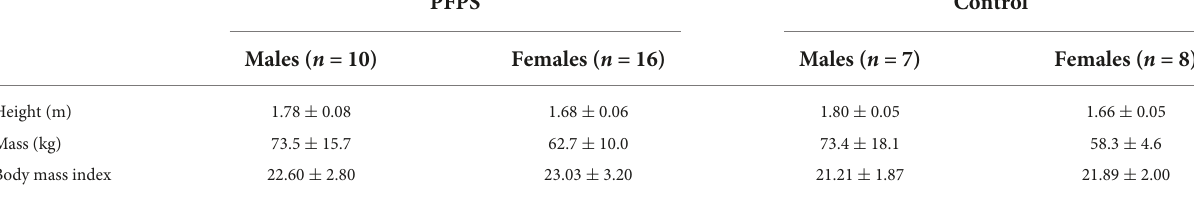
TABLE 1 Mean ± standard height and mass of the